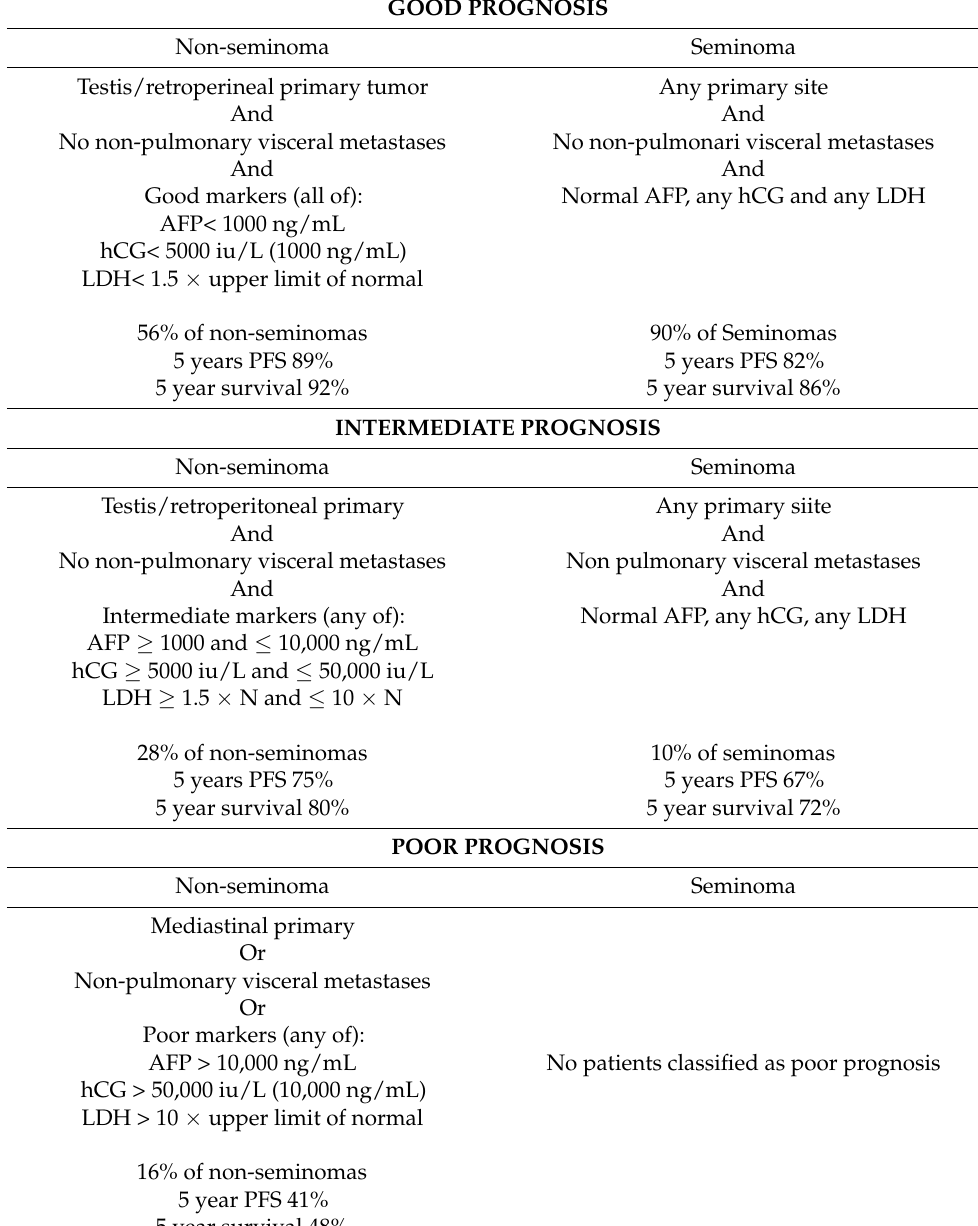
Table 2. TGCT prognosis classification guidelines by the IGCCCG [43]. The IGCCCG stratifies stage III patients according to three groups: good prognosis, intermediate prognosis, and poor prognosis. AFP: alpha-fetoprotein, hCG: human chorionic gonadotropin, LDH: lactic dehydrogenase and PFS: progression-free